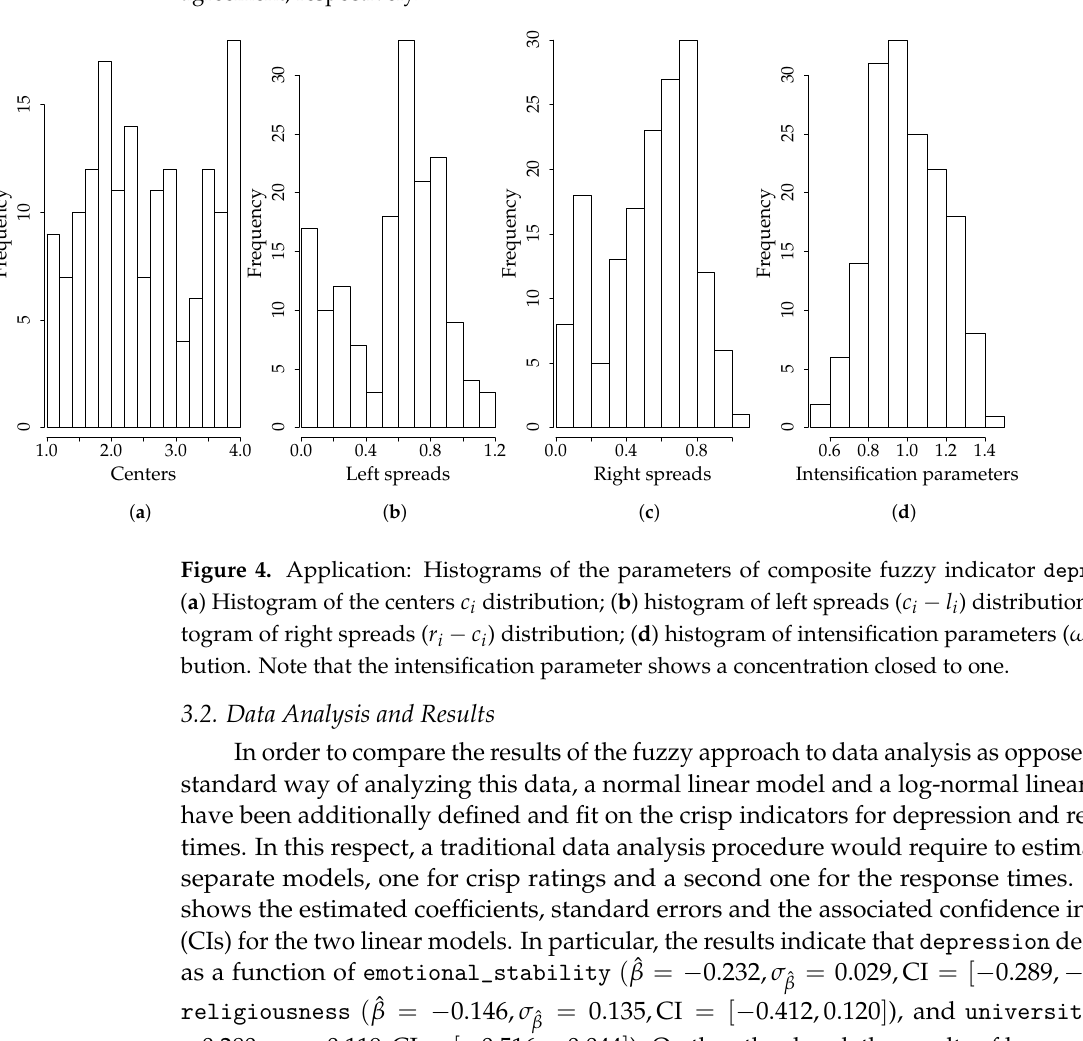
denote the decision nodes of disagreement, moderate agreement/disagreement, extreme agreement, respectively.